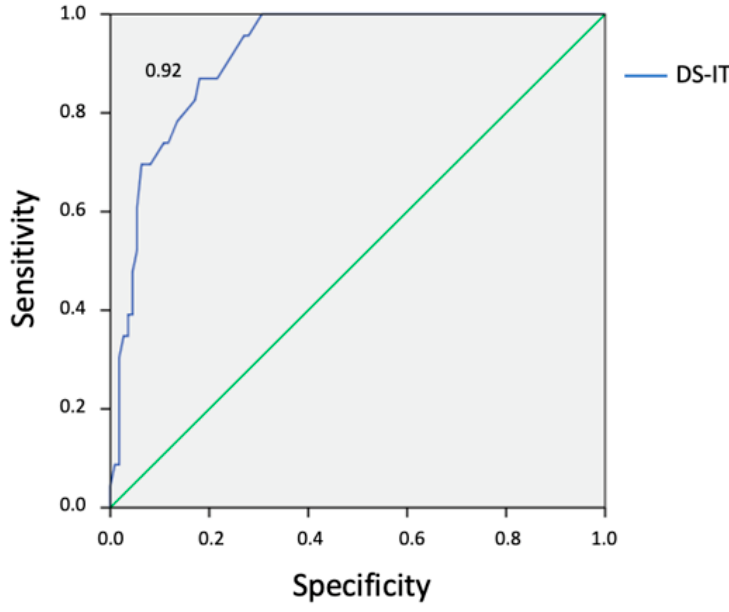
Figure 1. Receiver operating characteristic analysis of caseness on Diagnostic Criteria for Psychosomatic Research Interview—Demoralization section is illustrated. DS-IT: Demoralization Scale–Italian Version.